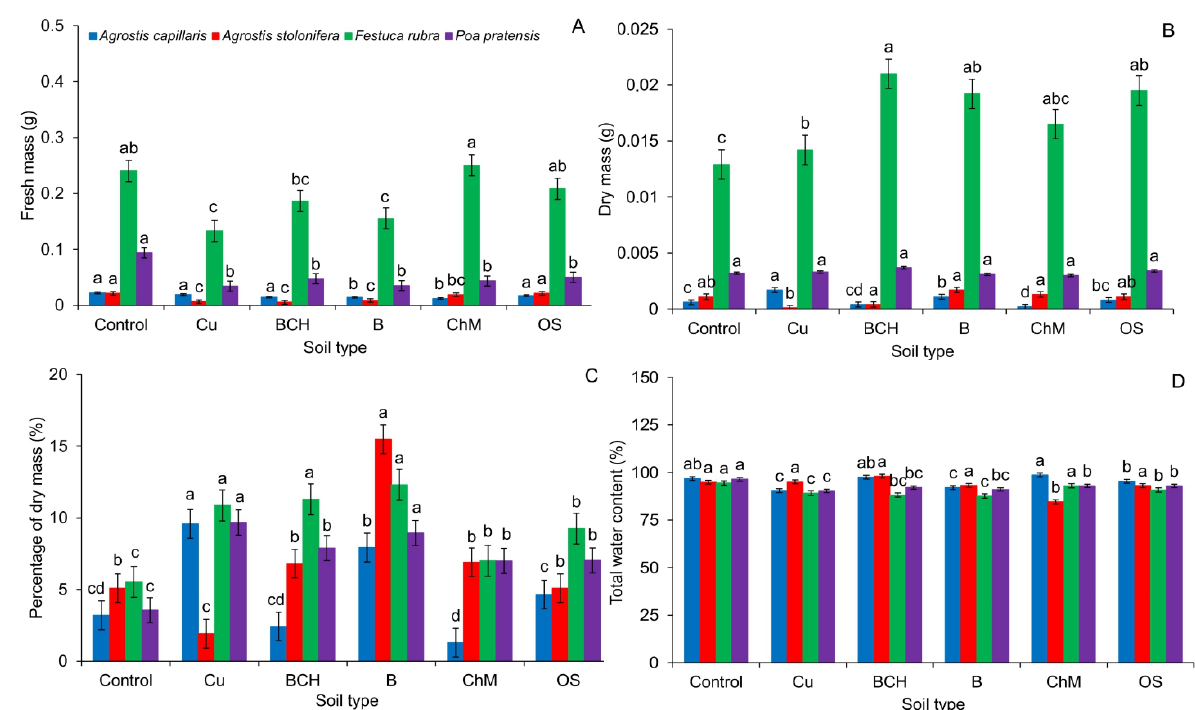
Figure 4. Values of fresh ( A ) and dry ( B ) mass, percentage of dry mass ( C ) and water content ( D ) in grass seedlings germinated on Petri dishes with various modifications of soil contaminated with copper; Cu—copper soil, copper soil with sorbents: BCH—biochar, B—bentonite, ChM—chicken manure, OS—organo-zeolitic substrate; mean values ( n = 5; ± SD) marked with different letters (within each species) differ significantly according to Duncan’s test with p ≤ 0.05.